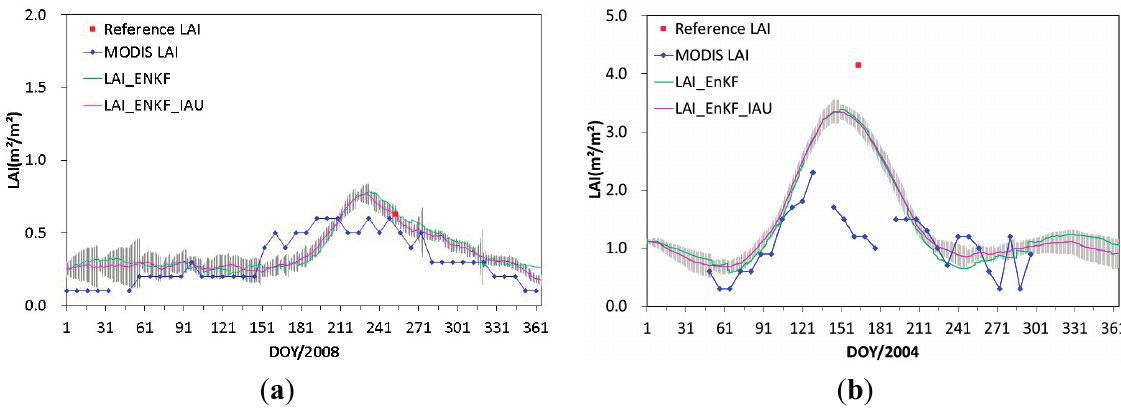
Figure 2. Retrieved LAI profiles by the inversion method with incremental analysis update (IAU) at the center pixel of ( a ) the Utiel site in 2008 and ( b ) the Demmin site in 2004.